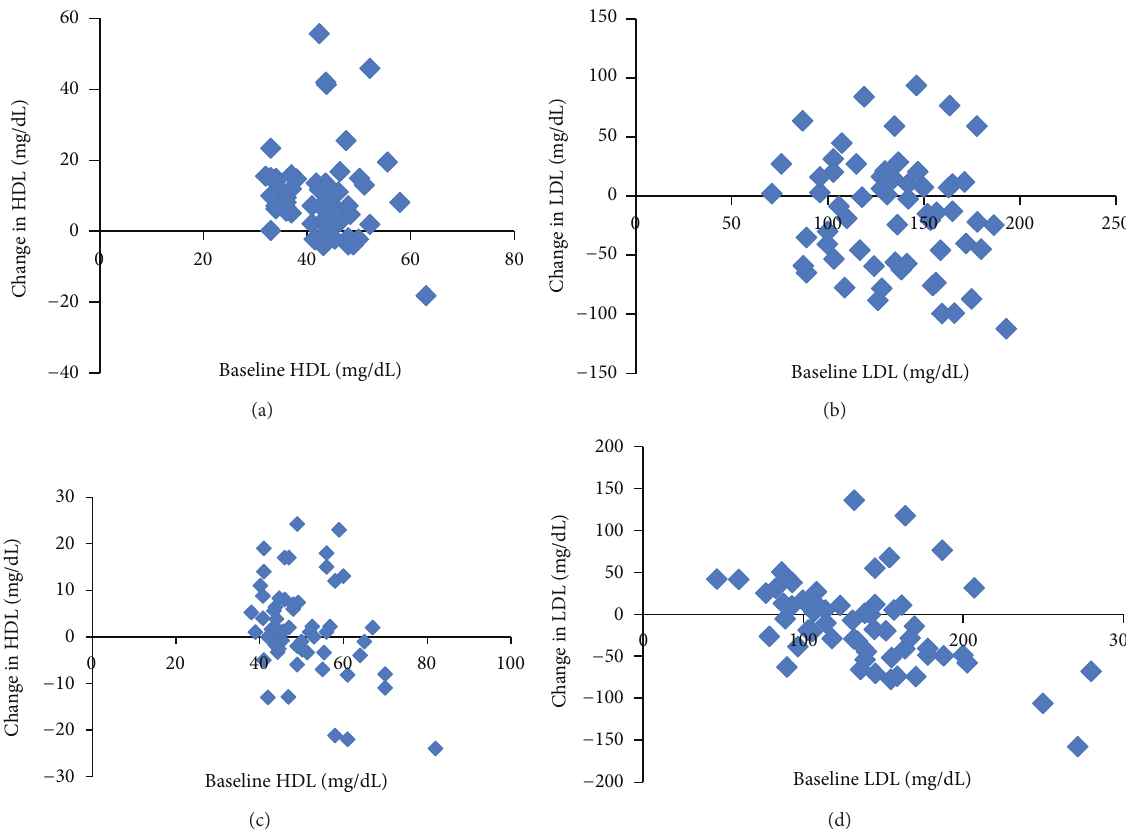
Figure 1: Correlation between baseline HDL, baseline LDL, and changes observed in HDL and LDL. (a) Baseline HDL and changes in HDL (CMP) ( 𝑟 = −0.14 , 𝑃 = 0.29 ), (b) baseline LDL and changes in LDL (CMP) ( 𝑟 = −0.17 , 𝑃 = 0.19 ), (c) baseline HDL and changes in HDL (SMP) ( 𝑟 = −0.35 , 𝑃 = 0.006 ), and (d) baseline LDL and changes in LDL (SMP) ( 𝑟 = −0.46 , 𝑃 = 0.001 ).